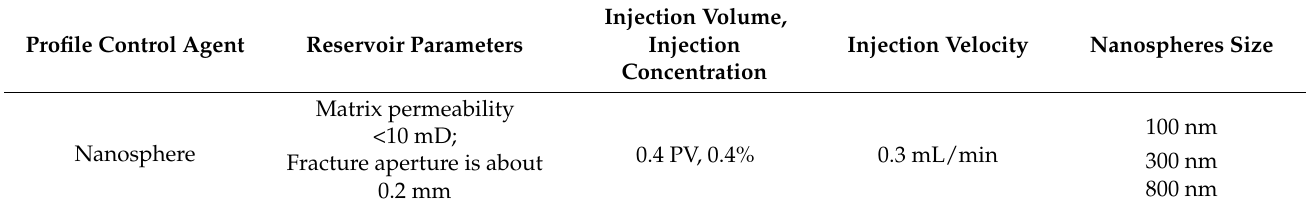
Table 5. Influence factors of nanospheres in low-permeability fractured reservoirs.